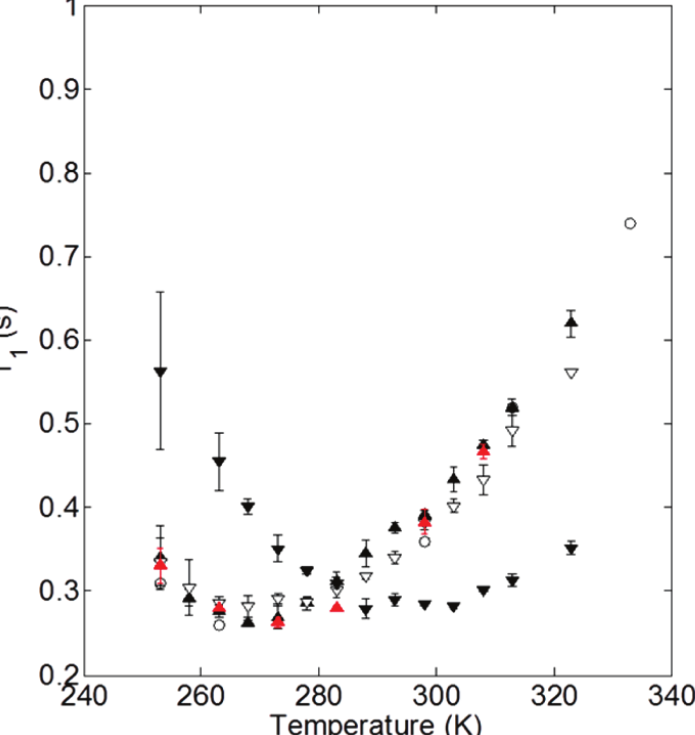
Figure 4. NMR spin-lattice relaxation times for M-2070 and M-600-based SiO 2 NIMs as a function of temperature. The data are shown for M-2070 ( ◦ ) and SiO 2 NIMs with 100% (filled (cid:78) ), 60% (open (cid:79) ), and 20% (filled (cid:72) ) neutralization of the SIT corona by M-2070 canopy. In addition, data are shown for 100% NIMs with one sodium cation per sulfonate group (red (cid:78) ). Reprinted with permission from Jespersen et al.